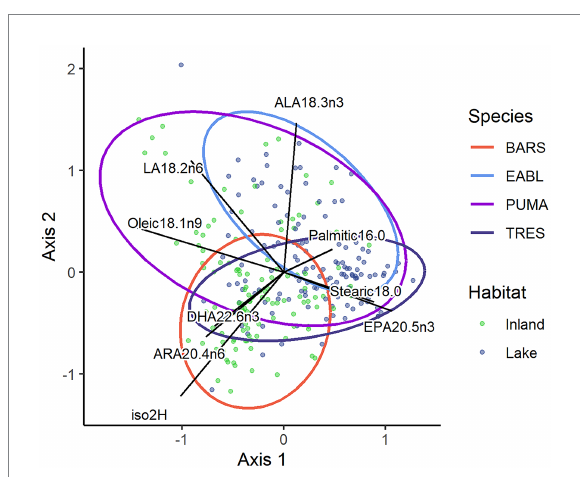
FIGURE 3 Redundancy analysis of standardized feather δ 2 H values (‰) and 8 notable plasma fatty acid percentages from purple martin (PUMA), tree swallow (TRES), barn swallow (BARS), and eastern bluebird (EABL) nestlings from inland (green) or lakeshore (blue) sites ( n =